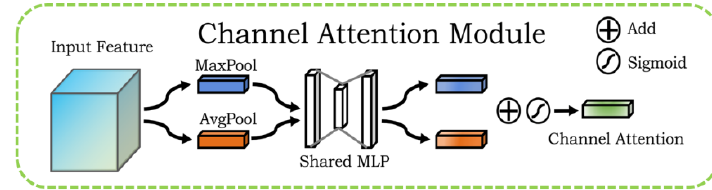
Figure 7. Channel attention module.